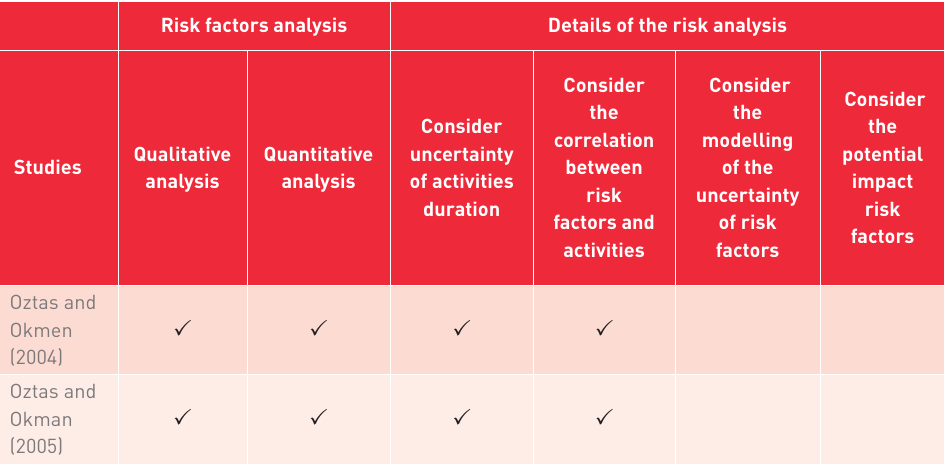
Comparison between simulation-based scheduling methodologies Risk factors